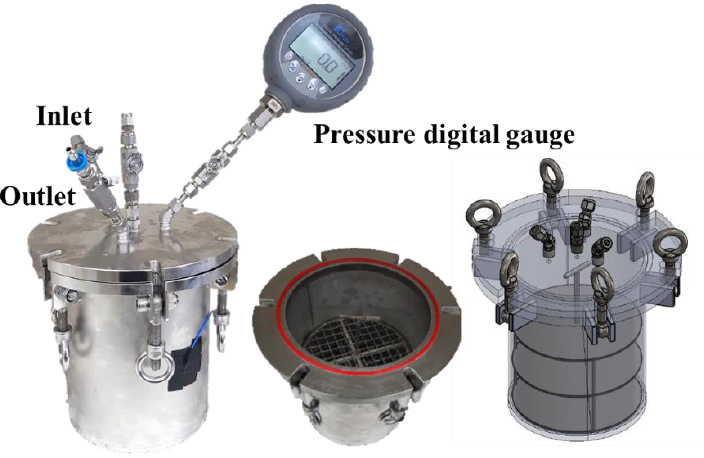
Figure 1. Pressure Figure 1. Pressure vessel.